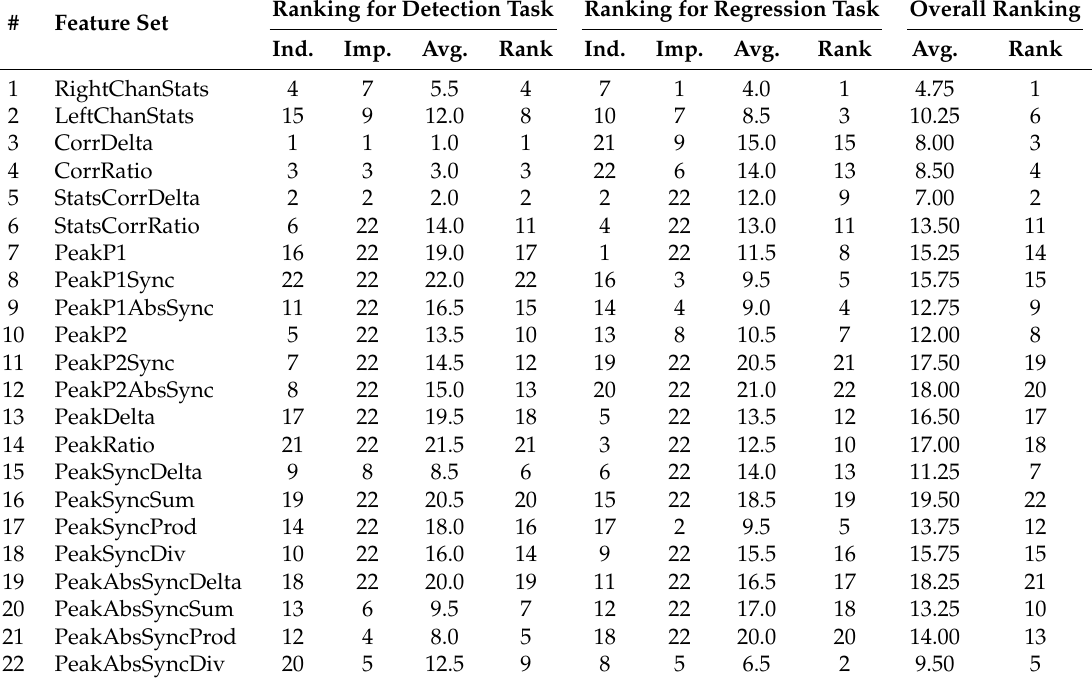
Table B1. Ranking of feature sets for club head speed prediction. Ind., individual; Imp., importance; Avg.,